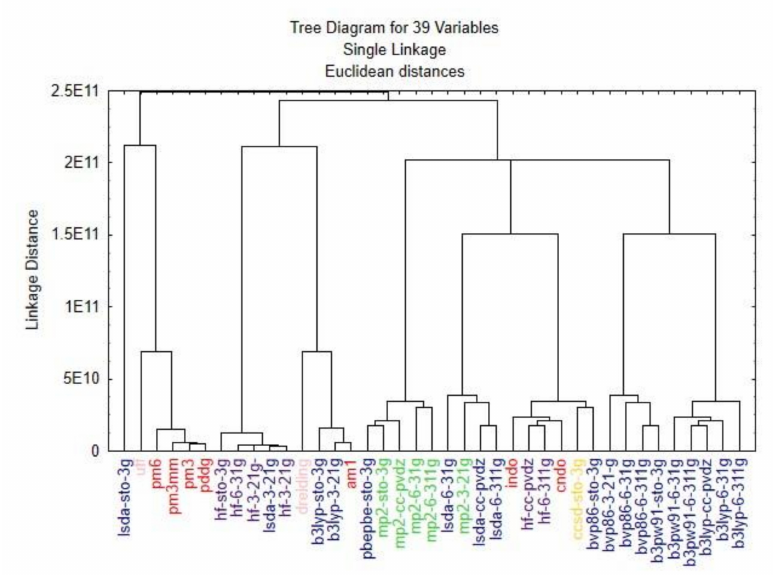
Figure 5. Clustering